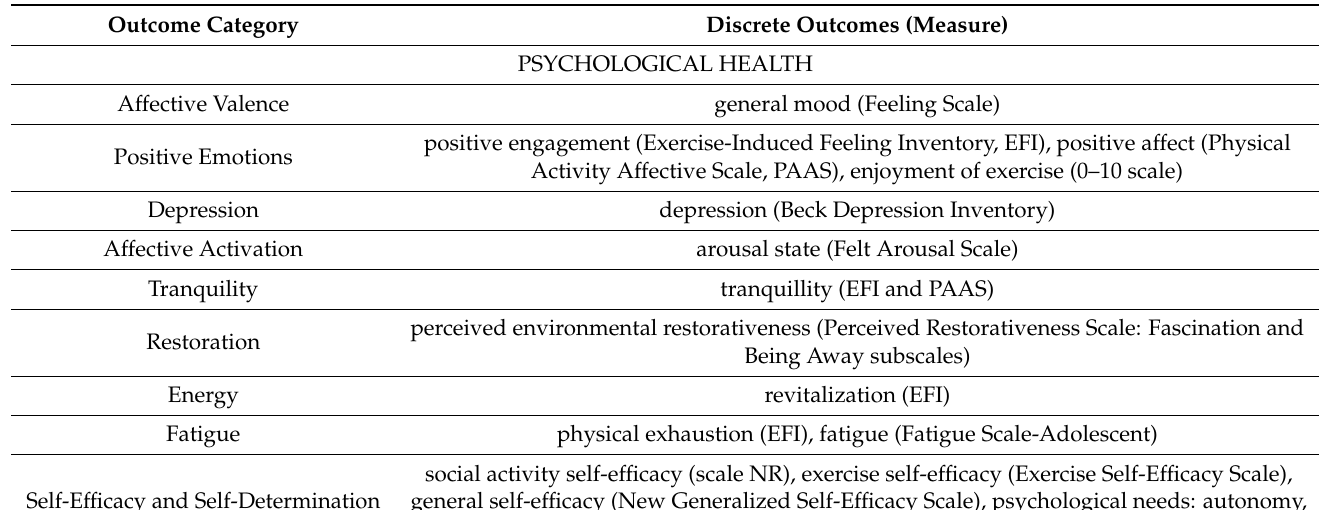
Table A1. Organization of discrete outcomes—as reported in each study—into broader outcome